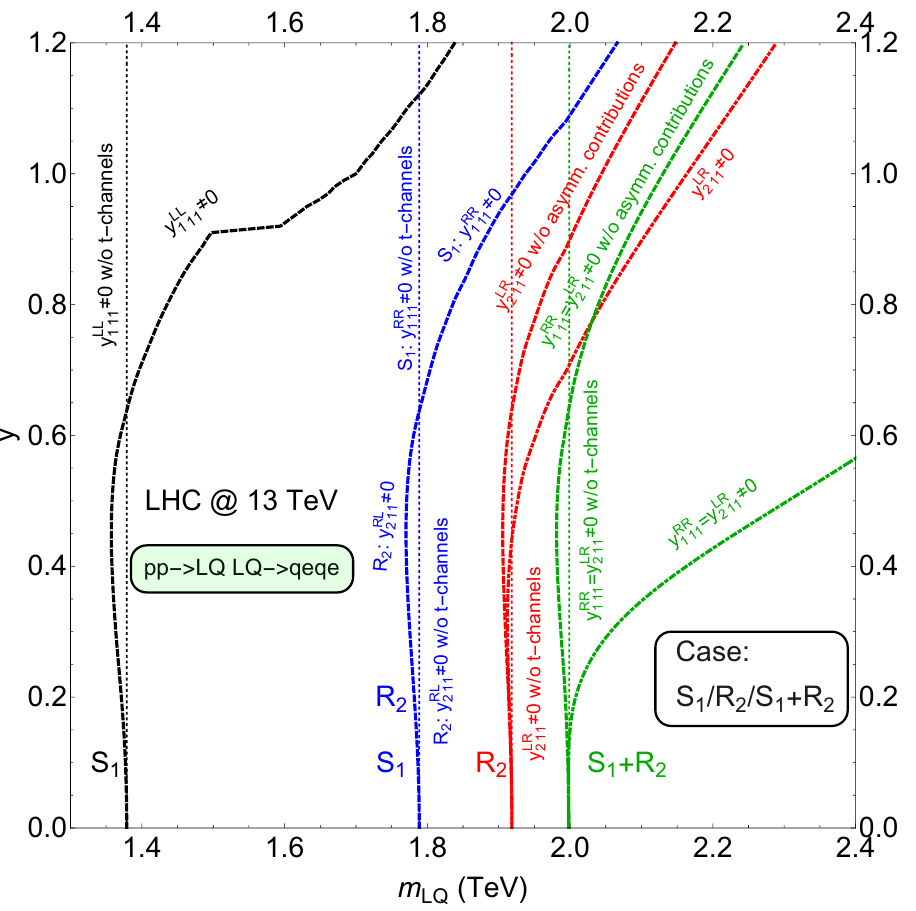
Figure 5 . The leptoquark parameter space limits for the S 1 , R 2 , and S 1 + R 2 scenarios extracted from the pp → LQLQ → jjee process search [1] performed at 13 TeV center-of-mass energy of proton-proton collisions at the LHC, using an integrated luminosity of 139 fb − 1 . See text for more